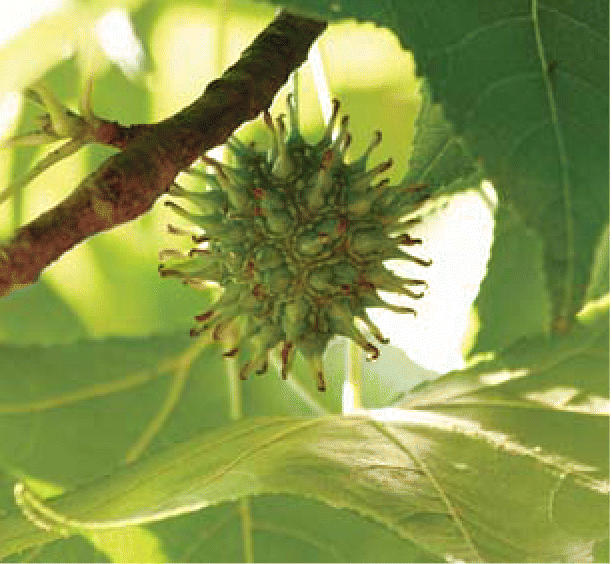
Sweetgum surpriseResearchers are finding new sources of shikimic acid.